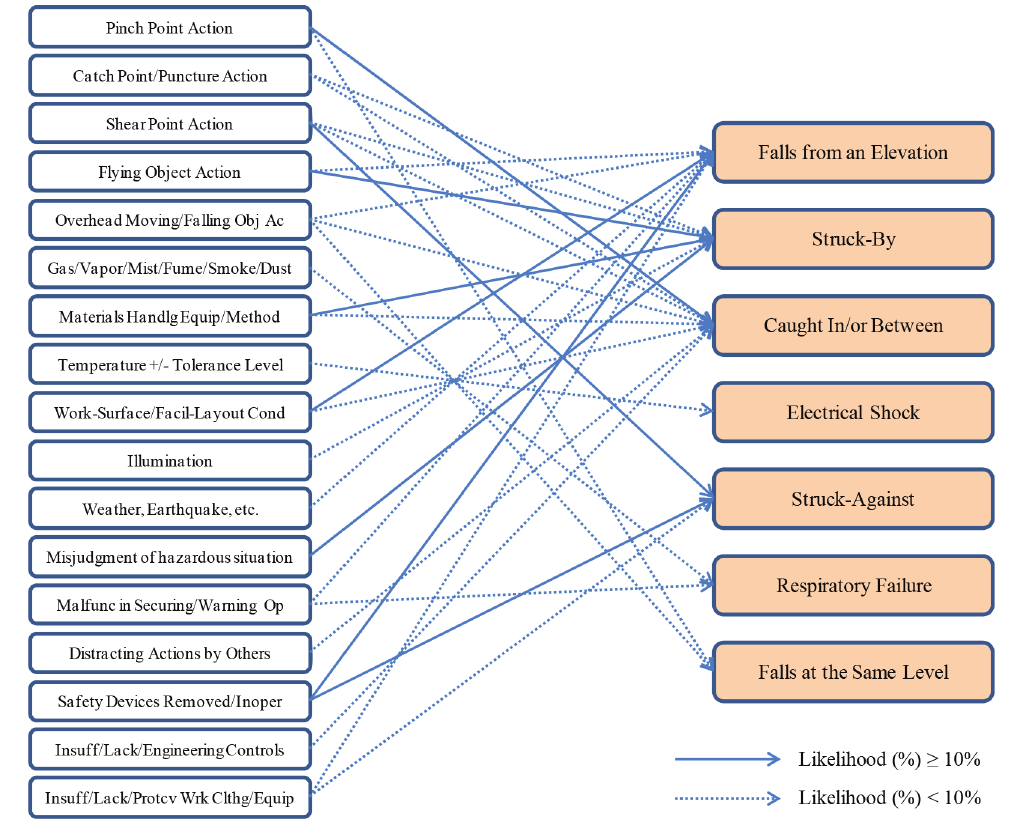
Fig. 2. Key relationships between risk factors and accident